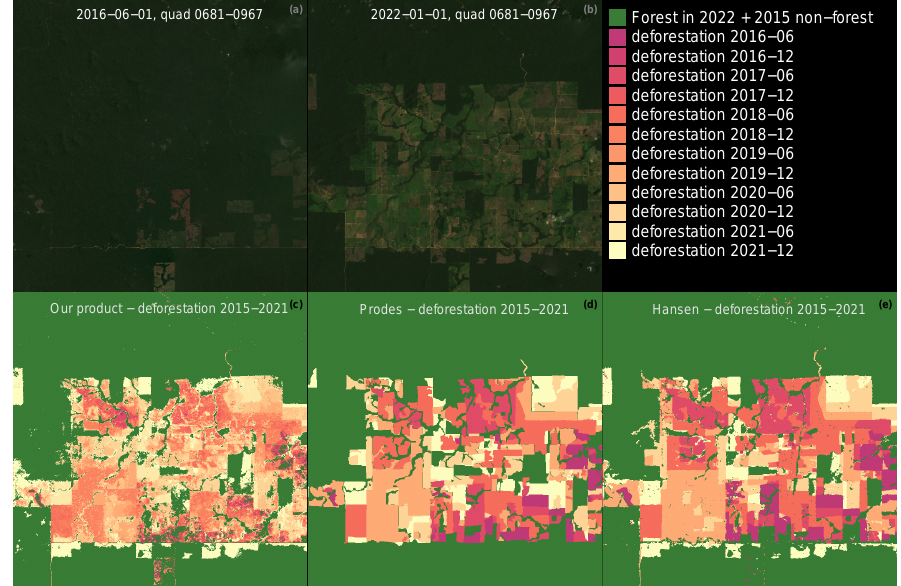
Figure 10. Change in tree cover for the Planet Nicfi quad 0681-0967 localized in Mato Grosso ( a , b ). Comparison of our product of deforestation ( c ) with the PRODES data ( d ) and GFC “tree loss year” ( e ) for this quad and for the period from 1 December 2015 to 1 December 2021. Planet NICFI quad is 19.5 19.5 ∼ ×